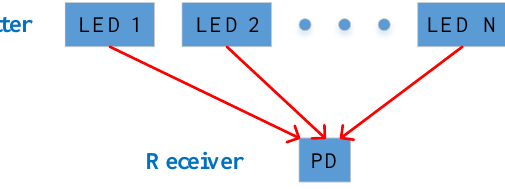
Figure 1. Multiple access system